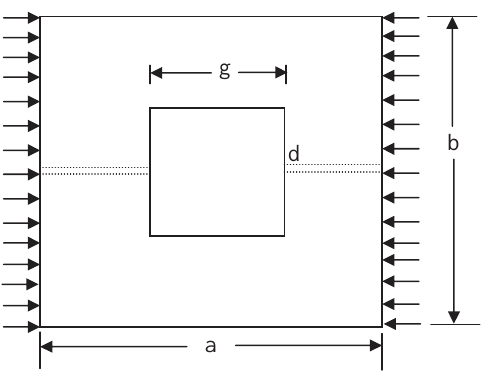
Fig. 1. Stiffened plates with cutout under in plane uniform edge loading at plate